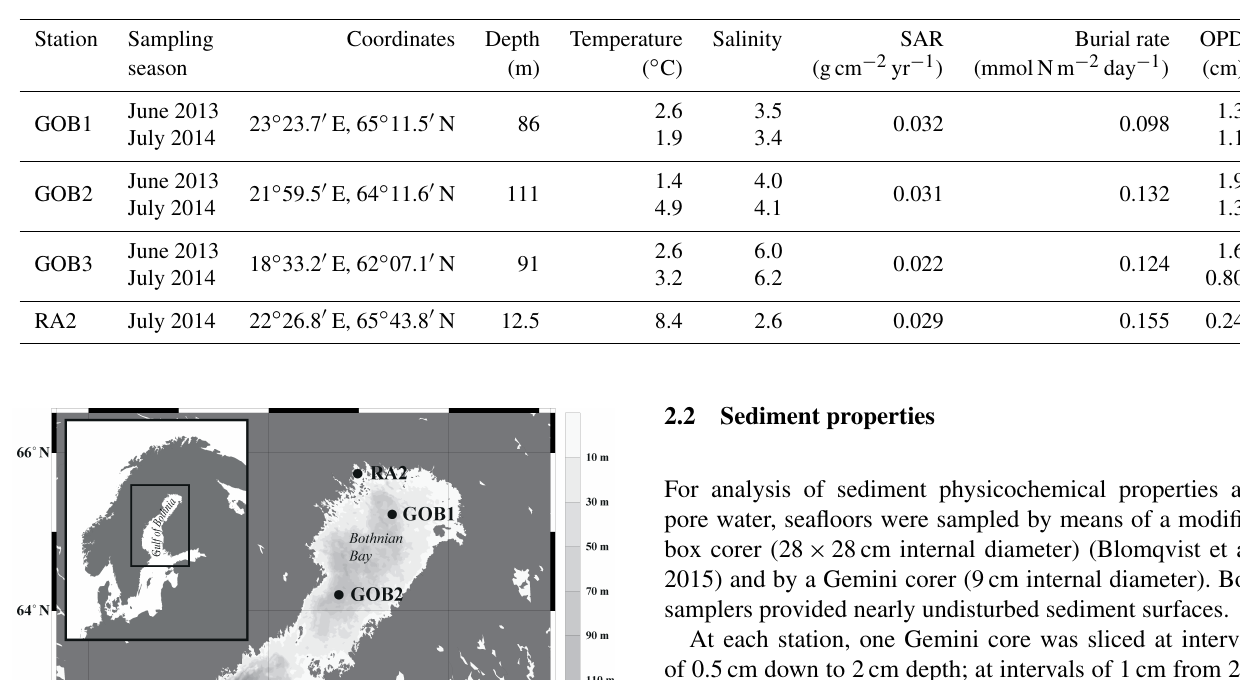
Table 1. Main site parameters obtained at the investigated sites. SAR is the sediment accumulation rate and, OPD is the average oxygen penetration depth.